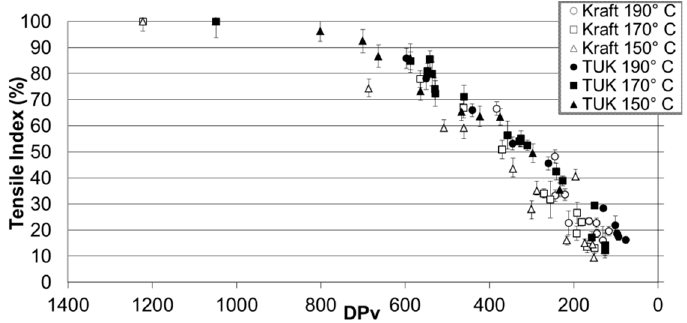
Figure 5. Degree of polymerization versus tensile index of paper samples, from [30].